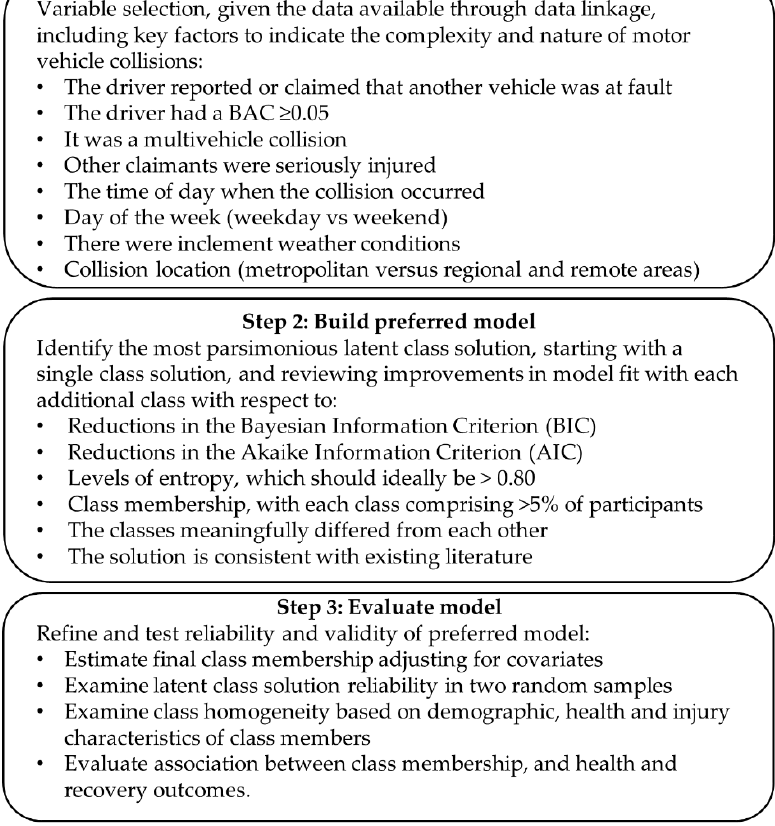
Figure 1. Flow chart of the latent class analysis methods.